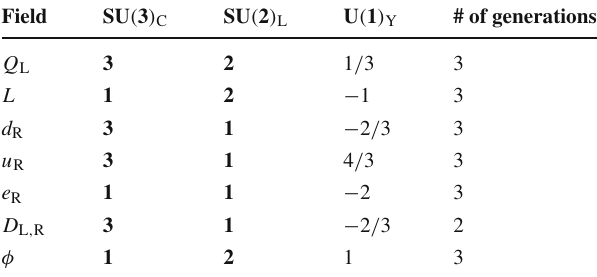
Bold values indicate charges of non-abelian